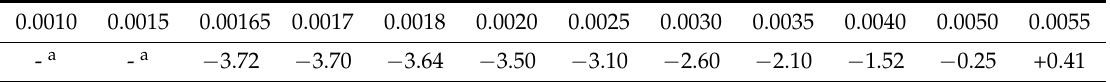
Table 1. Dependence of M06-2X/6–311++G(2d,2p) electrostatic potential V S,max of F along the S–F bond extension in SOF 2 ( V S,max values in bottom row in kcal mol − 1 ) on the nature of the isodensity envelope (values in top